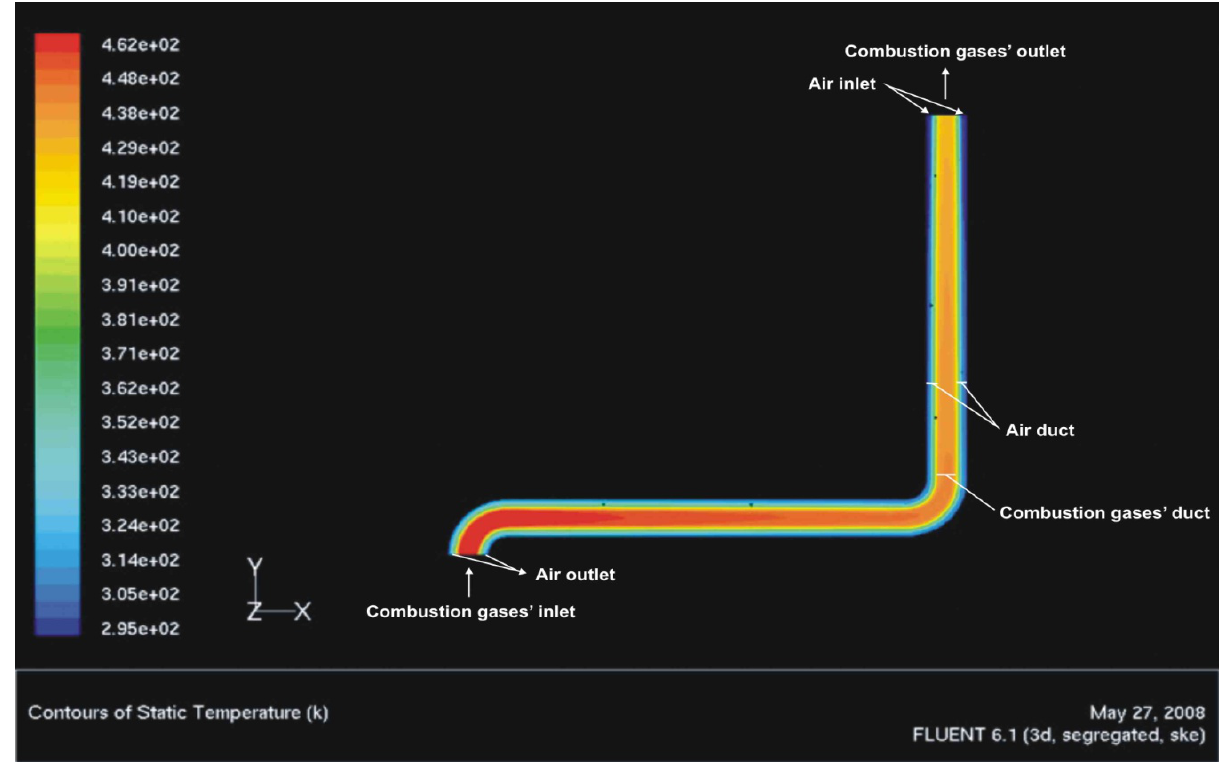
Figure 3. Sample temperature distribution (K) for the single chimney and air supply duct system with a length of 2 meters.